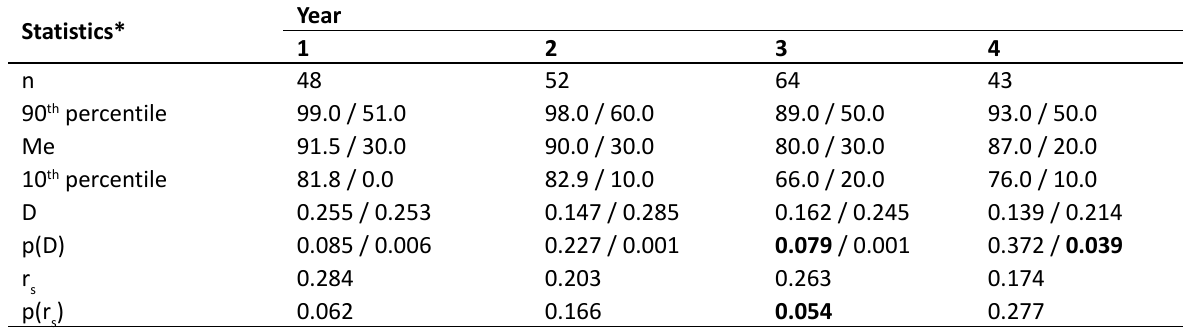
Table 1. Average score of the semester control / Scores of sport